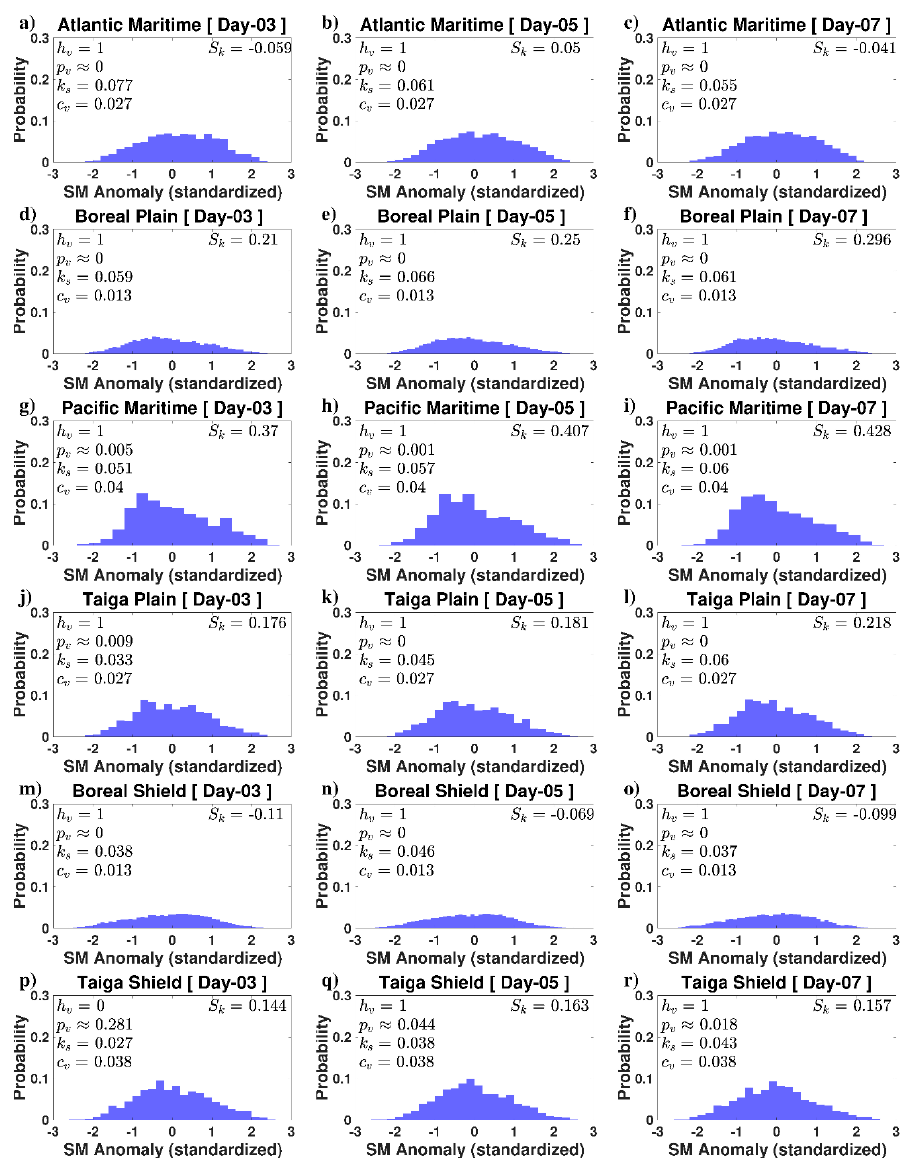
Figure 4. Histograms of the normalized soil moisture anomaly distribution at 3-days, 5-days, and 7-days (column-wise, left to right) prior to the occurrence of fire, for ecozones Atlantic Maritime ( a – c ), Boreal Plain ( d – f ), Pacific Maritime ( g – i ), Taiga Plain ( j – l ), Boreal Shield ( m – o ), and Taiga Shield ( p – r ), respectively. The parameters h, p, ks, and cv are MATLAB Kolmogorov-Smirnov (KS) test result parameters: ‘h’ is a logical value (0 or 1) indicating the hypothesis test result, i.e., h = 1 indicates rejection of the null hypothesis at the 5% significance level, and h = 0 indicates a failure to reject the null hypothesis. The parameter 'p' is the p-value of the test, ks is the test statistic and cv is the critical value of the test. If the test statistic (ks) is greater than the critical value (cv), then the KS test rejects the null-hypothesis. The parameter Sk (top right) indicates the skewness of the distribution. A positive skewness suggests a left leaning distribution, and vice versa. SM = soil moisture.